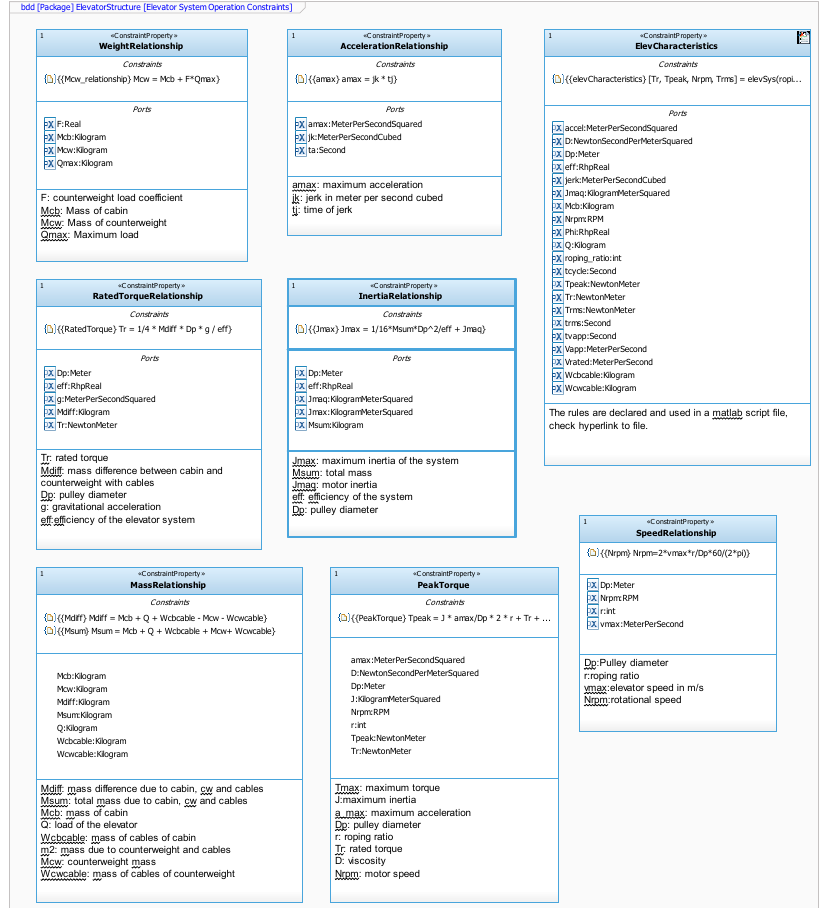
Figure 10. Equations modeling the elevator system operating characteristics.